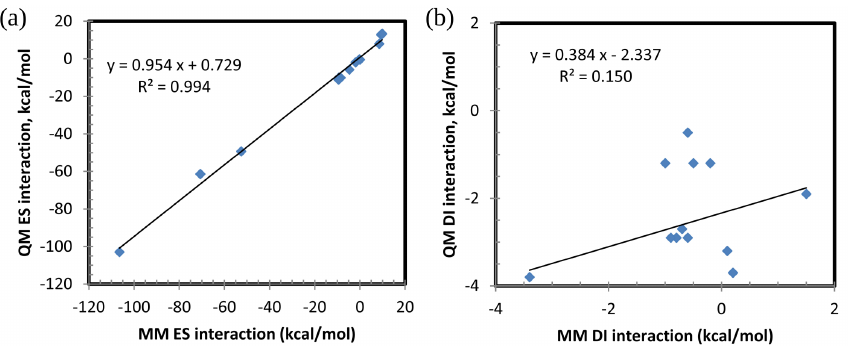
Figure 4. Correlation between components of pair interactions for conventional residues (res), MM vs. QM: ( a ) electrostatics (ES vs. elec) and ( b ) dispersion (DI vs. vdW).